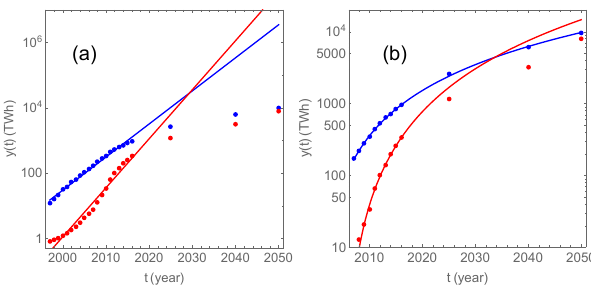
Figure 1. (a) Projected exponential growth of consumption of solar and wind power obtained by fitting a linear model to the logarithm of the consumption time series (the points to the left) for the two decades 1997–2016. Note that the vertical scale is logarithmic, so exponential growth is represented as a straight line.The red curve is solar PV power and the blue is wind power. The the red points to the right in the figure are the projected solar PV power consump- tion in the IEA 450 scenario for 2025 and 2040 and in the IRENA REmap scenario for 2050. The blue points to the right are the corre- sponding for wind power consumption. (b) The points are the same as in panel (a) , but the lines are power-law fits to the points for the decade 2007–2016 for wind power and 2008–2016 for solar